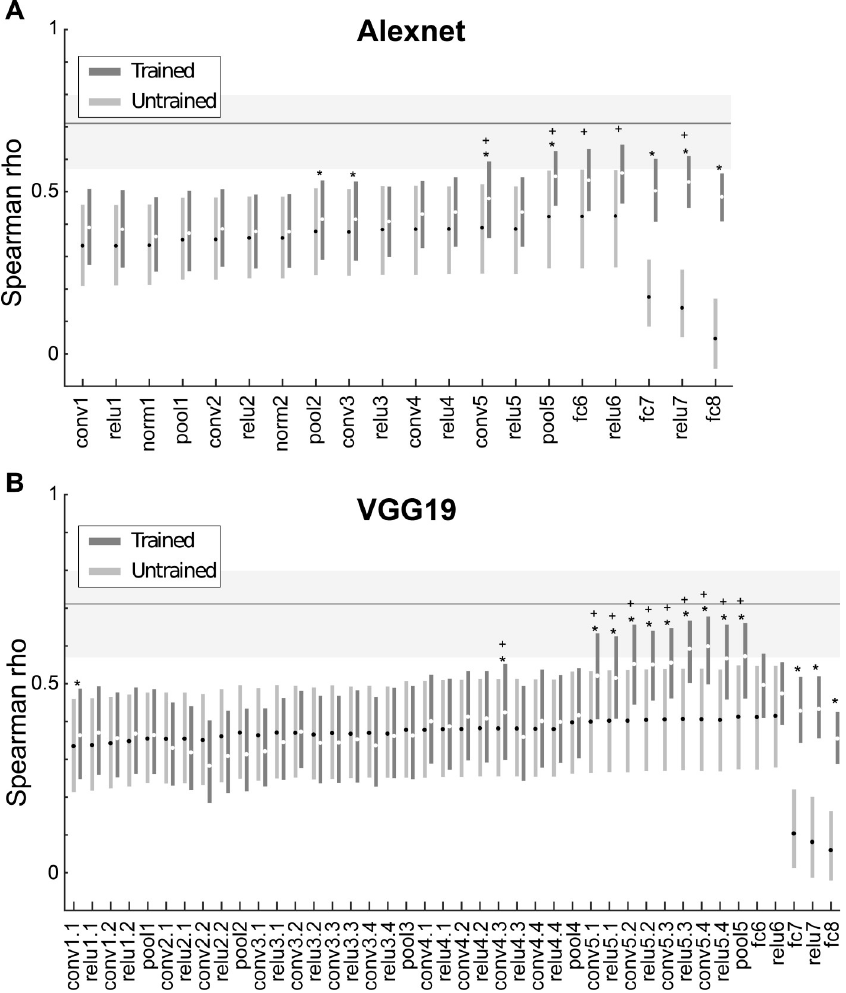
Fig 4. Representational similarity analysis of deep CNN layers and IT neurons for the whole shape set. Spearman rank correlation coefficients between IT and model layer similarities are shown for each layer of Alexnet (A) and VGG19 (B) using the Euclidean distance metric. Error bars depict 95% confidence intervals, determined by 10,000 bootstrap samples of the IT neuron pool (n = 119 neurons). Stars indicate layers for which the Spearman rank correlations for the trained version differed significantly from its untrained version (paired bootstrap test (see Materials and Methods); False Discovery Rate corrected q < 0.05). Crosses indicate trained layers which differed significantly from the first convolutional layer of the network (paired bootstrap test (see Materials and Methods); False Discovery Rate corrected q < 0.05). Layers are indicated by the same nomenclature as in Fig 2. The horizontal line and gray band indicate the median and 95% interval, respectively, of the Spearman-Brown corrected split-half correlations (n = 10000 splits) of the neuronal distances, as an estimate of the noise ceiling.